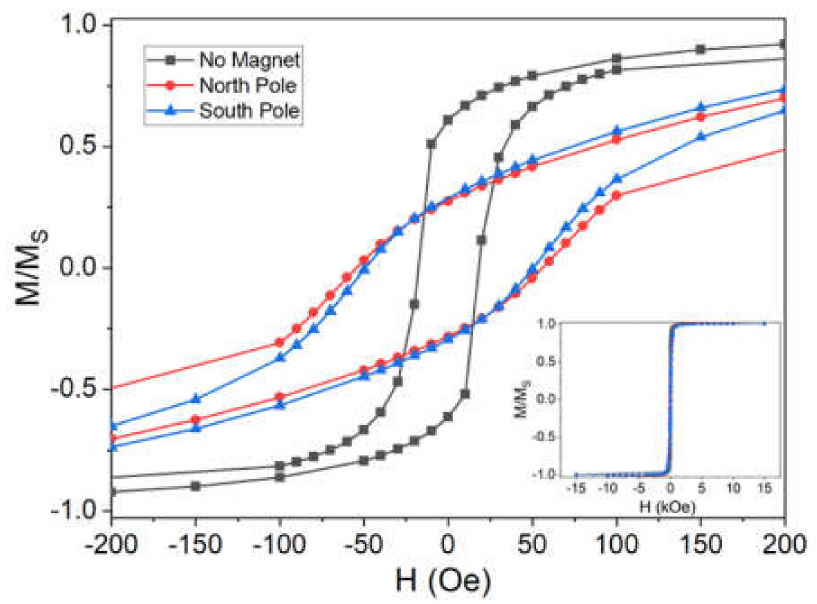
Figure 5. Magnetic hysteresis loops of the CoFeSn alloys deposited in absence and presence of the magnet under the electrode. A magnification of the hysteresis is reported; the wide view of the analysis is presented in the